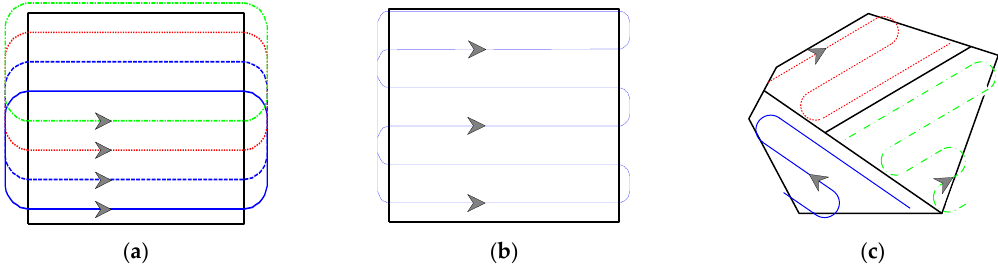
Figure 3. Three schematic diagrams of persistent coverage based on different methods . ( a ) An example of the parallel scanning coverage; ( b ) An example of the sequential scanning coverage; ( c ) An example of the area ‐ decomposition based coverage.